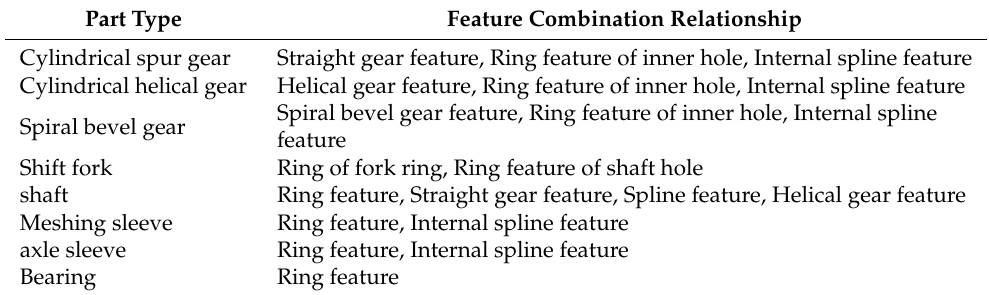
Table 1. Combination relationship between parts and various features.